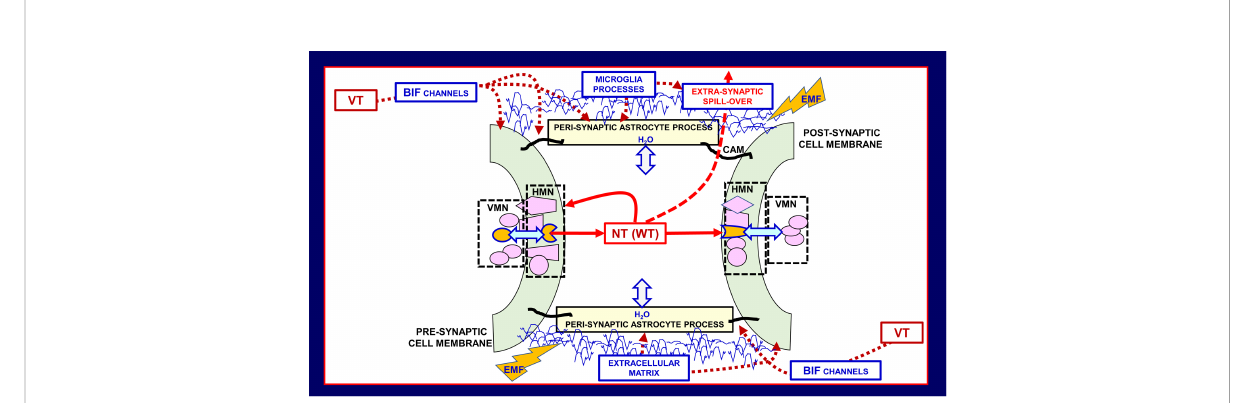
FIGURE 4 Schematic representation of the main morpho-functional features of the penta-partite synapse (PPS). Astrocytes, extracellular matrix, and neurons together with microglia build up PPS. VT signals can reach the PPSs via the Brain Interstitial Fluid channels (BIF channels) impinging on them. Besides the classical pre- and post-synaptic sides, of basic importance for the integrative function of the PPSs are the several molecular components indicated in the scheme, and microglial cytokines/chemokines involved in brain homeostasis and in homeostasis loss in